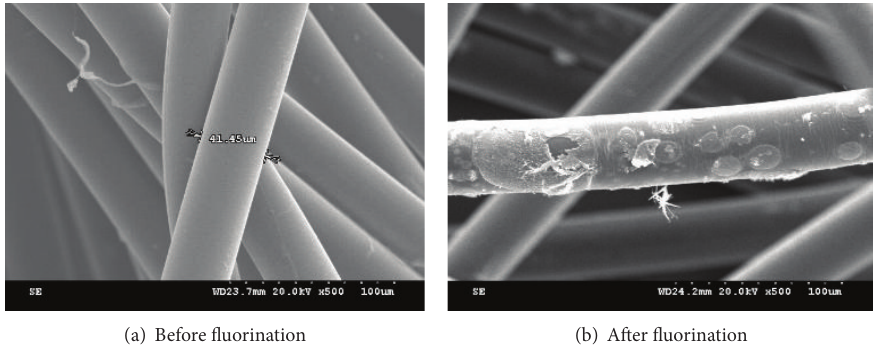
Figure 1: SEM images before and after fluorination of polypropylene fiber [9].